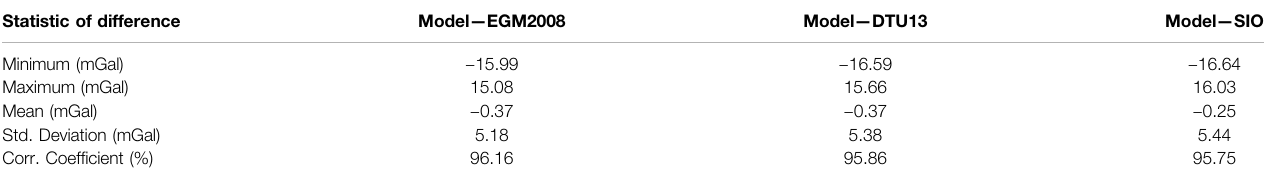
TABLE 4 | Comparing modelled gravity anomaly with reference models.